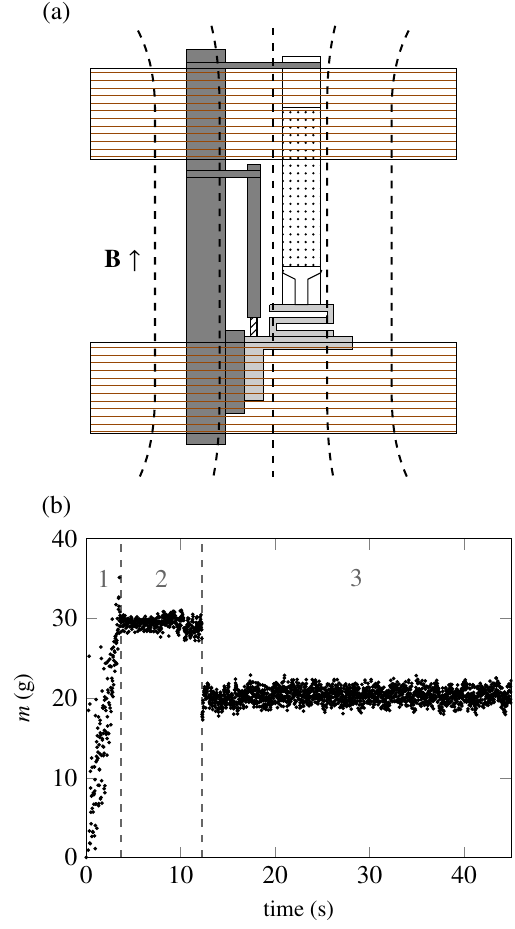
Figure 1. (a) Sketch of the experimental set-up with the gen- eration of a homogeneous vertical magnetic field, using coils in a Helmholtz configuration. (b) Typical mass measurement, 1. beads are poured inside a tube using a hopper until we reach the desired mass m0, 2. the packing is at rest and the hopper is re- moved, 3. downward movement of the vertical translation stage, the mass measurement corresponds to the mean plateau